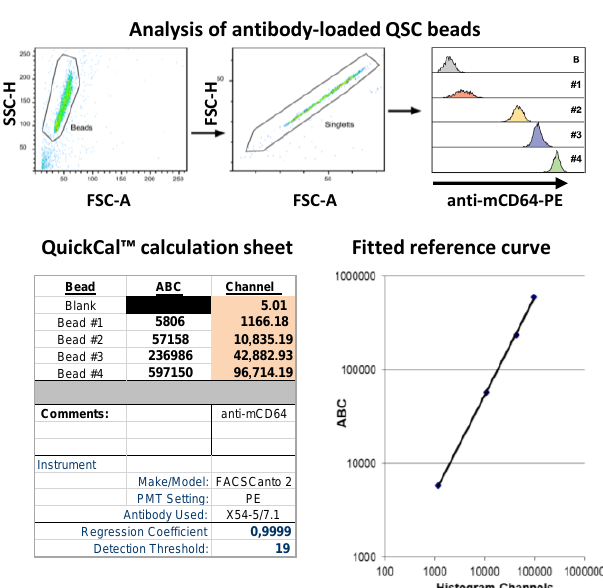
Figure 2. Impact of enzymatic digestions on FcγR expression analysis. ( A ) Depicted are the flow cytometric analyses of alveolar macrophages isolated by BAL (upper panels) or in enzymatically digested lung tissue (lower panels). Fluorescence intensities are shown for a respective FMO control (light ocher and light-blue histograms) or for cells stained with PE-conjugated antibodies directed against the indicated FcγRs. X-axis scaling for the BAL samples is identical to the depicted scaling of the tissue samples ( B ) Histograms showing the fluorescence intensities of the indicated murine peripheral blood leukocytes upon staining with PE-conjugated antibodies that are specific for the indicated FcγRs. The blood samples have been incubated without enzymes (lower panels) or with collagenase D, Dispase ® and DNase I (upper panels) prior to antibody staining. X-axis scaling for the enzymatically treated samples is identical to the depicted scaling of the untreated samples. ( C ) Depicted is—as an example—the establishment of an anti-CD64 (FcγRI) reference curve for the deduction of the number of anti-FcγR-binding sites presented as the antibody-binding capacity (ABC) from the median fluorescence intensity. Five different types of QSC beads with known anti-mouse IgG-binding sites were loaded with an anti-FcγR antibody and analyzed by flow cytometry. Aggregated beads were excluded, and the fluorescence intensity of each single bead population was measured (upper panel). In the lower left panel, an excerpt from a QuickCal™ calculation sheet is shown, in which the detection threshold and quality of fitting (represented by the regression coefficient) are calculated from the known ABC values of the beads and measured fluorescence intensity (“channel”). The lower right panel depicts the reference curve for CD64 fitted to the anti-CD64-binding capacity (ABC) vs. fluorescence intensity (histogram channels) of the reference beads.